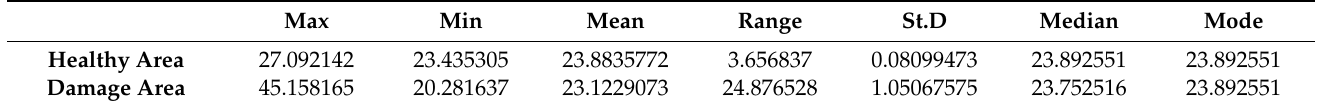
Table 8. Statistical results for thin sample based on transmission mode row